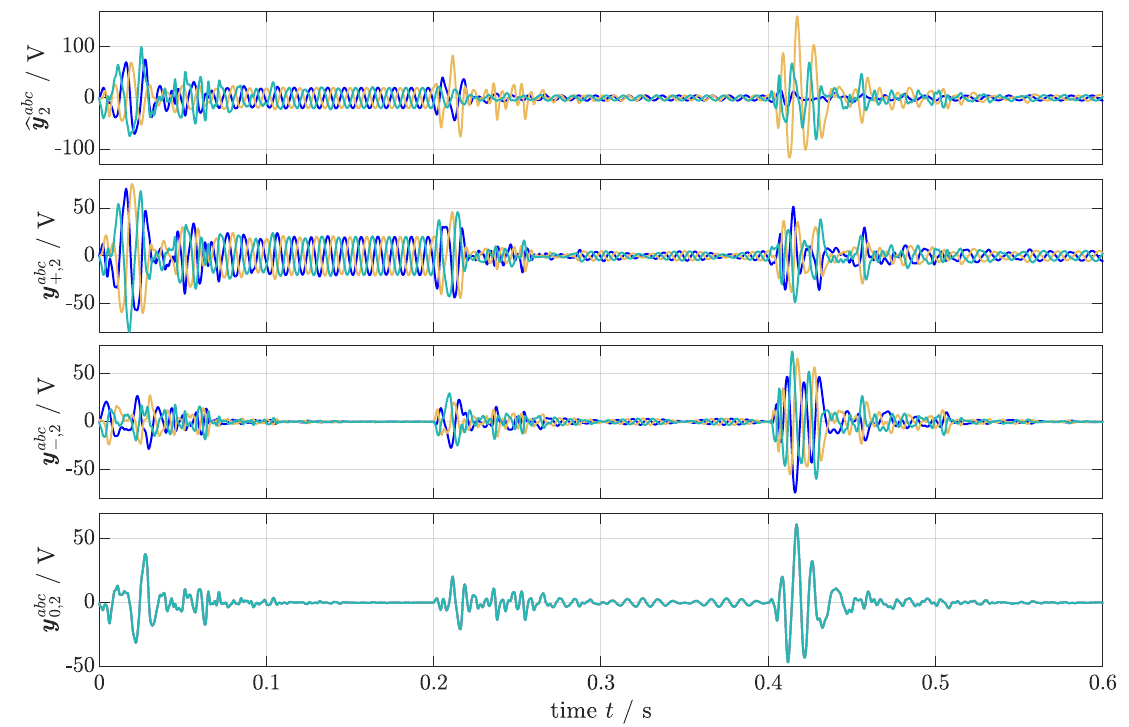
Figure 12. Simulation results for Scenario (S4): Estimated in-phase signals (cid:98) y abc y abc + y abc − y abc ,2 , negative- ,2 and zero-sequence 0,2 of the second harmonic component (phase